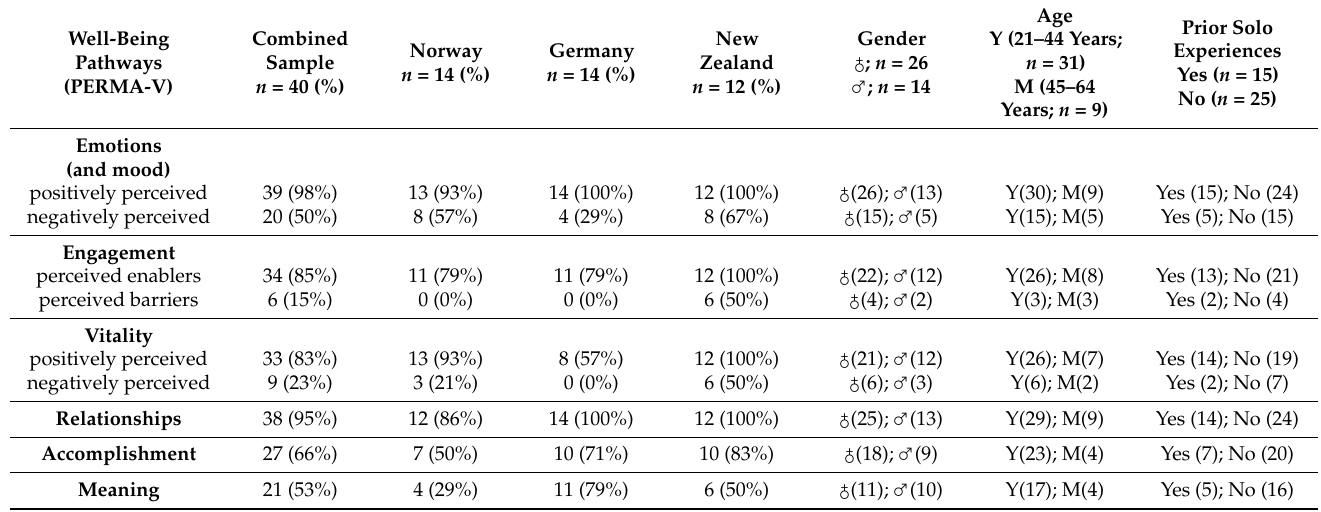
Table 2. The six well-being pathways by national sample, gender, age (younger vs. middle-aged) and prior solo experiences. Well-Being Pathways